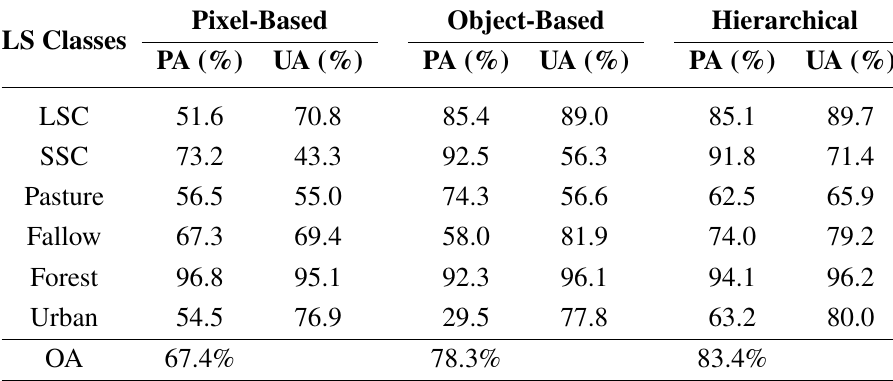
Table 2. Accuracy assessment: comparison of pixel-based, object-based and hierarchical classification (PA = producer’s accuracy, UA = user’s accuracy, OA = overall accuracy) with error-adjusted estimates [86].